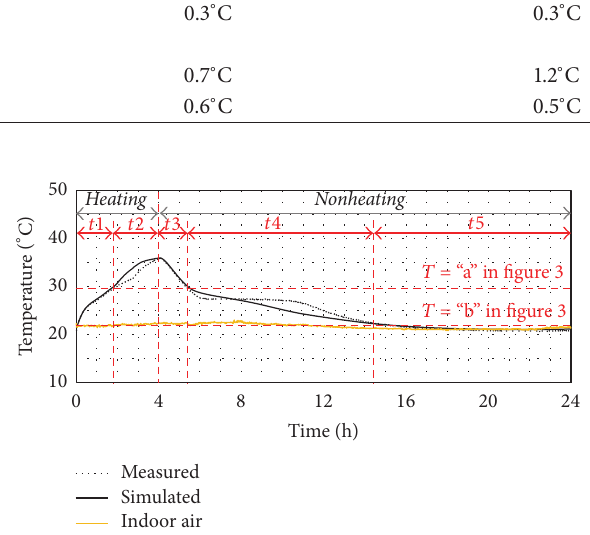
Figure 8: Detailed temperature distribution at the middle point of concrete with